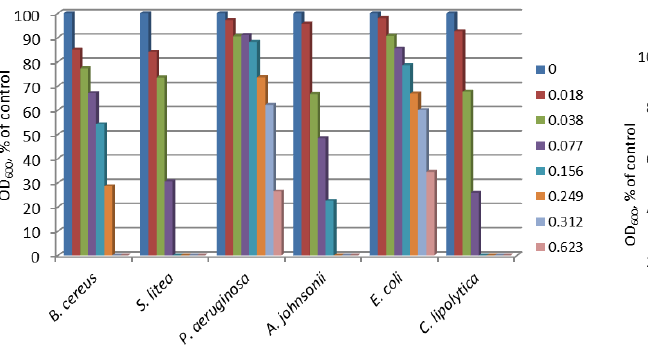
Figure 5: Growth of the tested model microbial strains in presence of different concentrations of compound E.